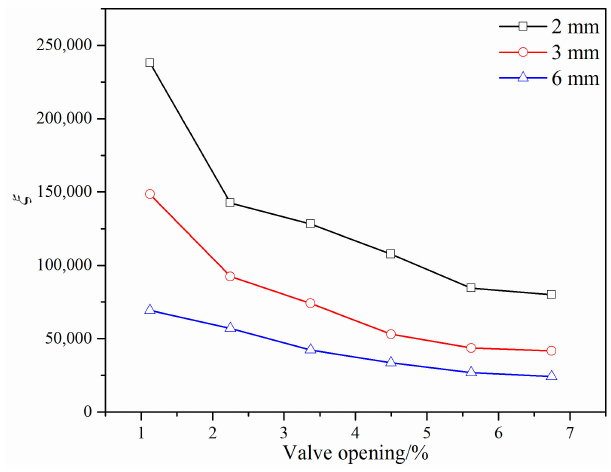
Figure 14. Loss coefficient of the improved #2 V-ball valve under different valve openings.